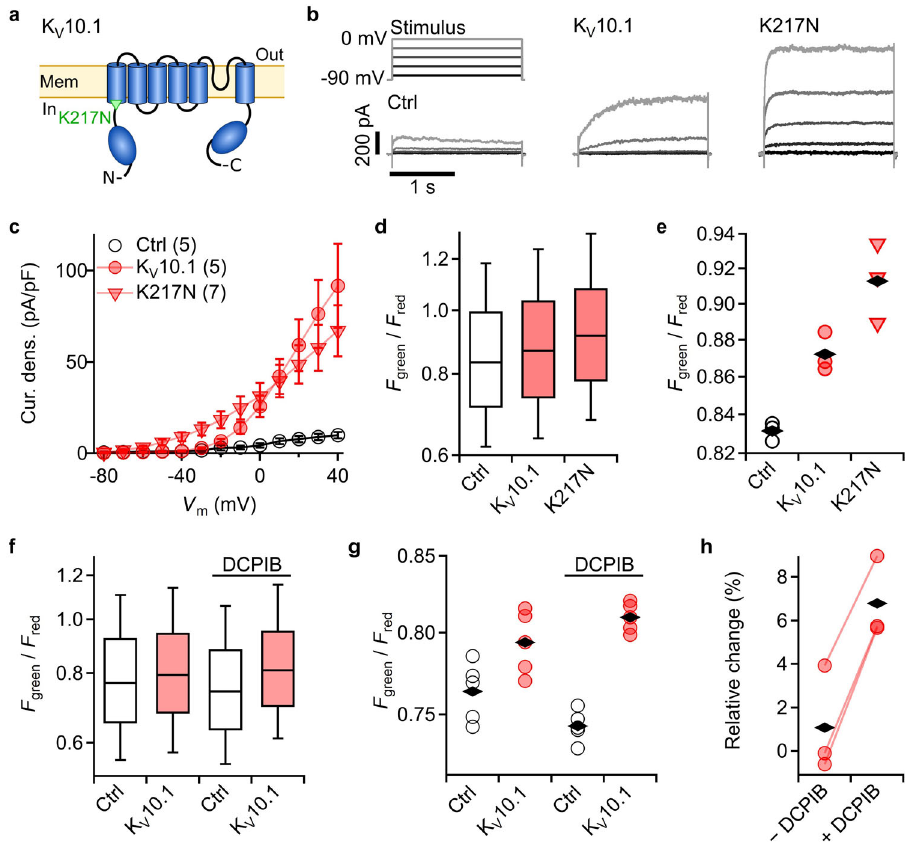
Fig. 4 Kv10.1-K217N, a causative mutation for Temple-Baraitser syndrome, strongly hyperpolarizes HEK293T cells. a Schematic of one of four subunits forming a functional human ether à go-go channel (Kv10.1). Point mutation K217N shifts the current-voltage relationship to more negative voltages. b Representative current traces of HEK293T cells expressing rASAP alone (Ctrl) or coexpressing Kv10.1 or Kv10.1-K217N. Current traces were acquired using the depicted voltage pulse protocol. Control recordings were acquired from cells without Kv10.1. c Current density as a function of the voltage of cells expressing rASAP alone or coexpressing the indicated Kv10.1 variant. Data points are means ± sem, n is given in parentheses. Straight lines connect data points for clarity. d Boxplots of F green / F red from HEK293T cells expressing rASAP alone or coexpressing the indicated variant. e Median ratio values of three independent samples (as in ( d )) measured on the same day; black rhombi are average values; cells >4400 for each measurement. f F green / F red of cells expressing K V 10.1 with and without 10 µ M of the Cl − channel blocker DCPIB. g Median ratio values of fi ve independent samples (as in ( f )). h Relative change in F green / F red of cells with K V 10.1 over control cells with and without DCPIB from three days; connected data points are average changes acquired on the same